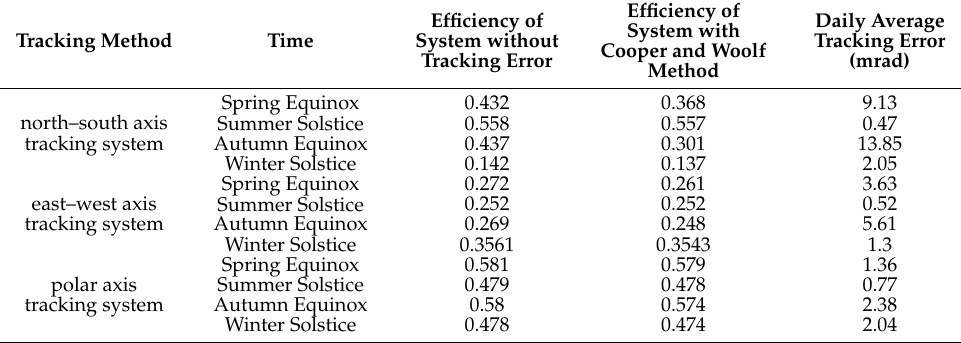
Table 3. At spring equinox, summer solstice, autumn equinox and winter solstice, efficiency of parabolic trough system with the Cooper and Woolf method and efficiency of system without tracking error under different tracking